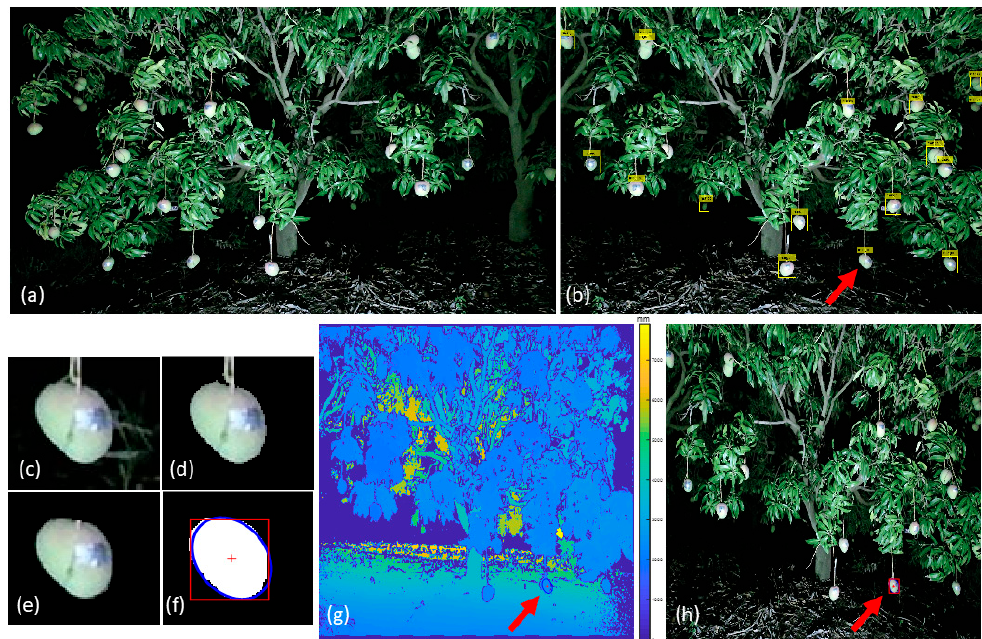
Figure 3. Fruit detection method: ( a ) original input Kinect RGB image; ( b ) cascade fruit detection using HOG features; ( c ) an identified fruit by cascade fruit detection; ( d ) background removal with Otsu’s method and color thresholding; ( e ) stalk filtering; ( f ) and ( g ) depth registration; ( h ) fruit size calculated from bounding box side lengths; with ( g ) displaying the point of depth registration on a single fruit and its bounding box. The red arrow points to the same fruit in panels b , g and h , and this fruit is shown in panels c – f .